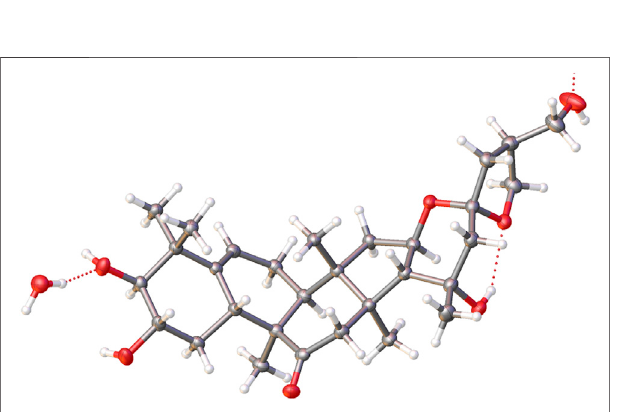
FIGURE 5 | Key 1 H- 1 H COZY, HMBC, and NOESY correlations of compounds 5 and 6 .